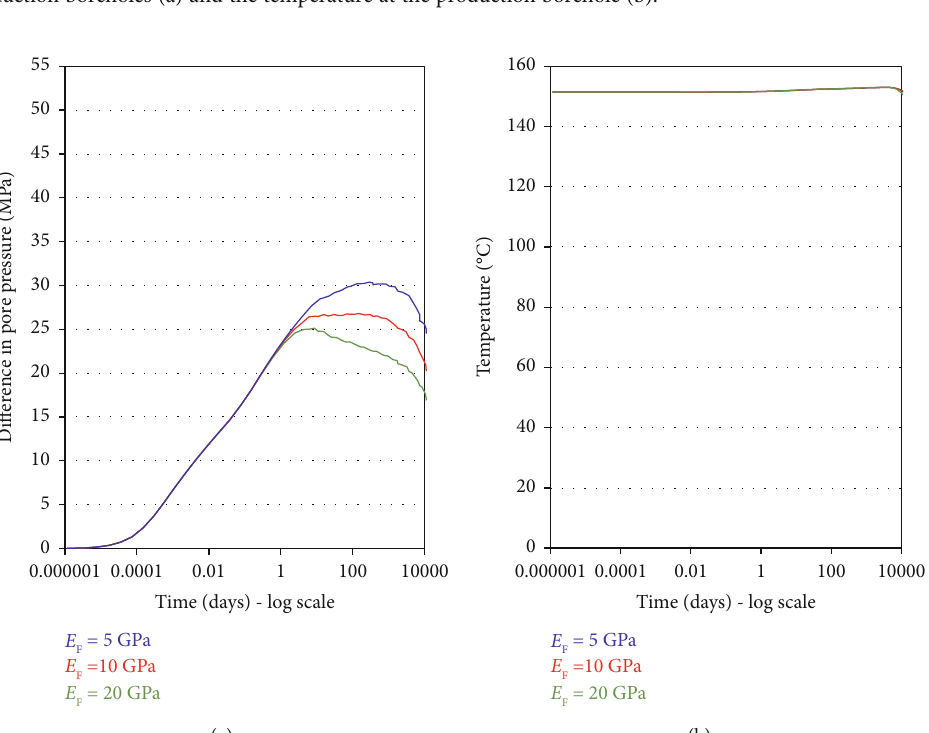
ff erence in the fl uid pore pressure between the Figure 11: E ff ect of the permeability k F of the fracture zones on the time evolution of the di injection and production boreholes (a) and the temperature at the production borehole (b).